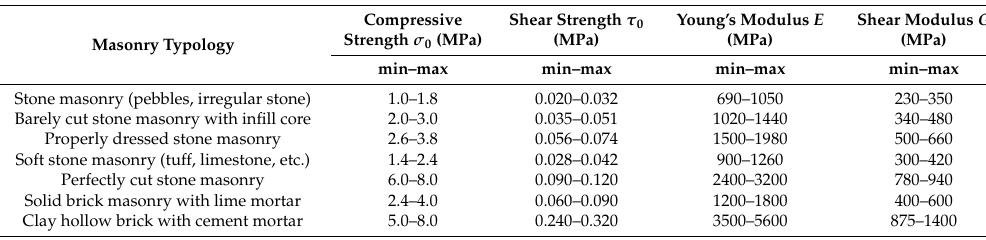
Table 3. Italian Standard (2009): masonry mechanical properties.